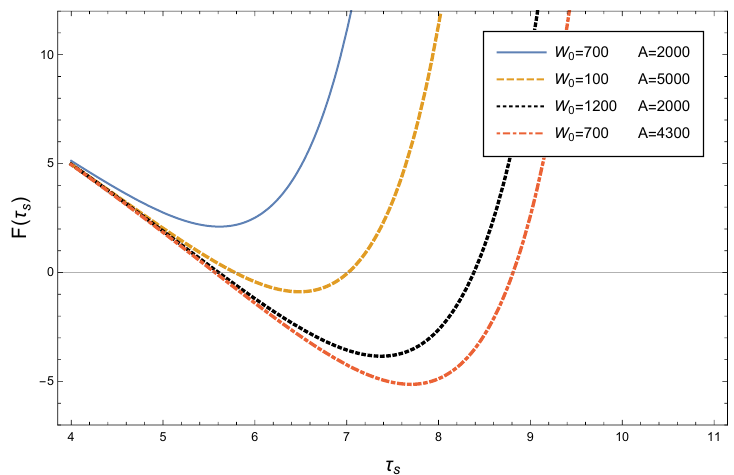
Figure 5. The plot shows (4.30) for different choices of the parameters W 0 and A , with all other parameters fixed. Critical points for the scalar potential (4.22) exist when F ( τ s ) = 0 . We see that the product W 0 A (which appears in the equation (4.29)) needs to be large enough for a solution to